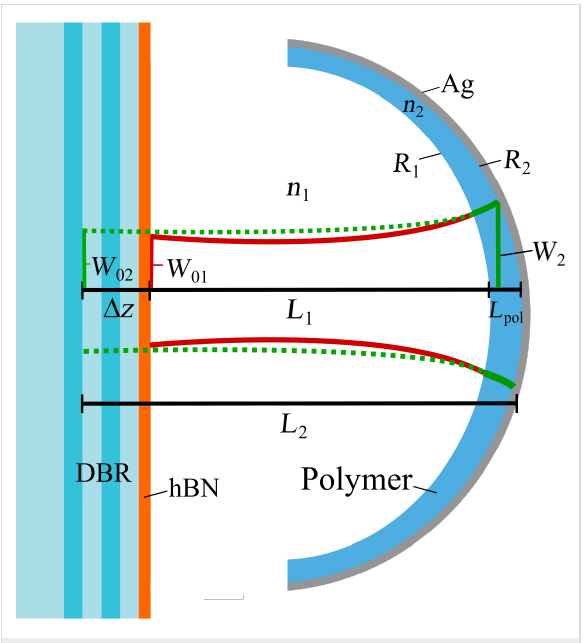
Figure 3: Cross-section of hybrid plano-concave microcavity shows the geometrical parameters and the two Gaussian modes inside.